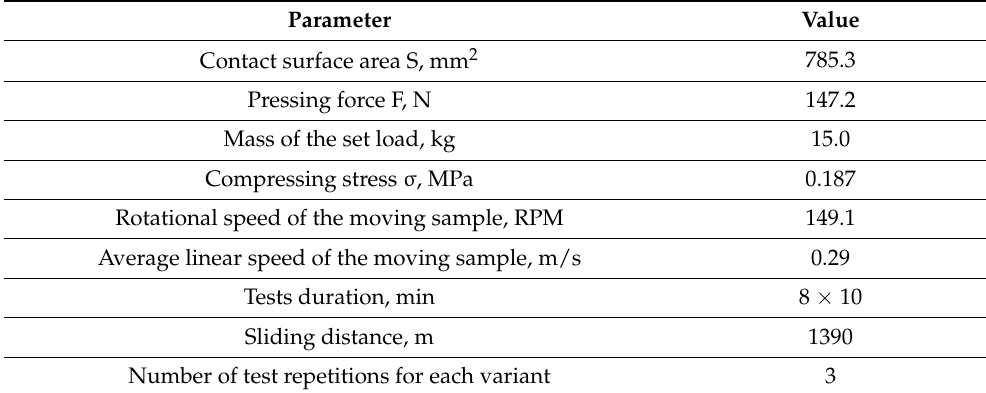
Figure 2. Tribotester; ( A )—test stand, ( B )—schematic diagram of the wear testing method, ( C )—view of a sample immediately following the test; designations: 1—test head of the stand, 2—drive shaft, 3—upper sample holder, 4—lower sample holder, 5—fixing elements, 6—test sample (6a—upper sample and 6b—lower sample), and 7—stand base with motor. Table 1. Main parameters of the wear tests.